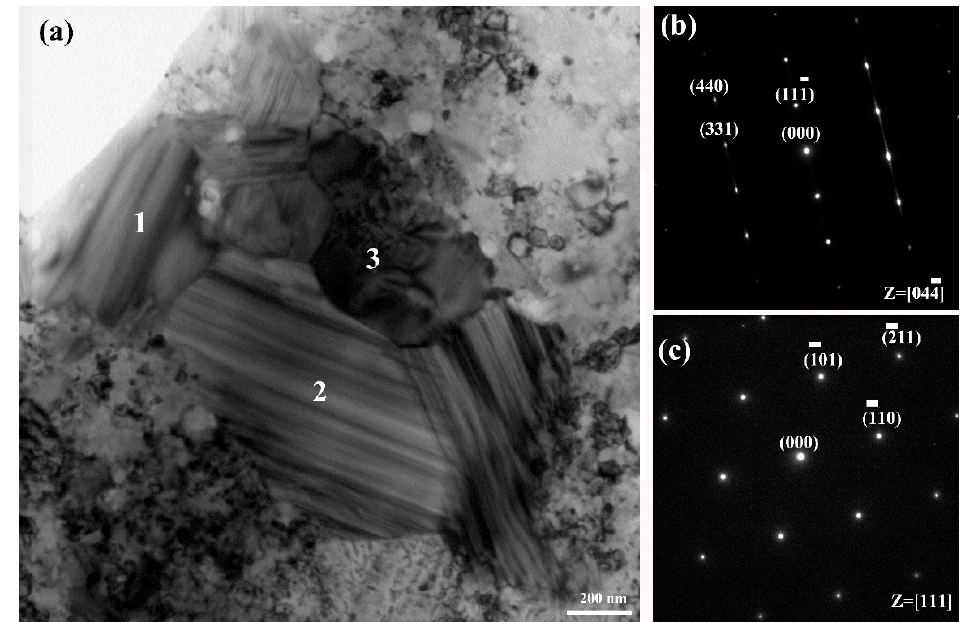
Figure 8. ( a ) TEM bright field image of 25 vol.%TiB 2 /Fe-15Cr-10Mn-5Al composite and three intermetallic grains 1, 2 and 3; ( b ) corresponding SAED demonstrating grain 2 in ( a ) corresponding to CrFeB with orthorhombic crystal symmetry along (cid:3427)044(cid:3431) zone axis; ( c ) corresponding SAED demonstrating grain 3 in ( a ) corresponding to Fe 2 AlCr with BCC crystal symmetry along [ 111 ] zone axis.